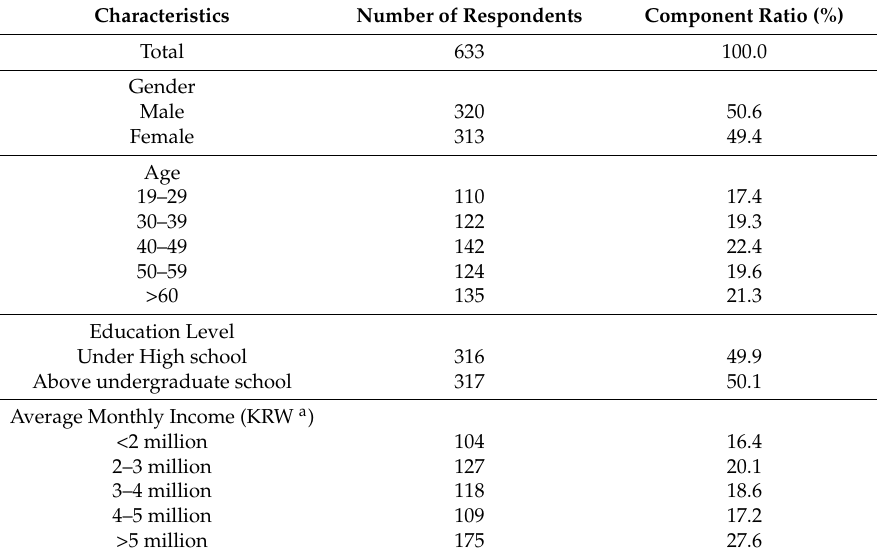
Table 2. Descriptive statistics of the